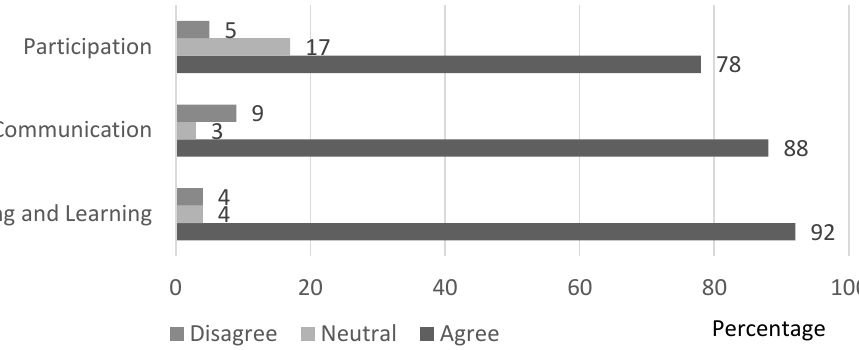
Figure 3. Benefits enjoyed by lecturers and